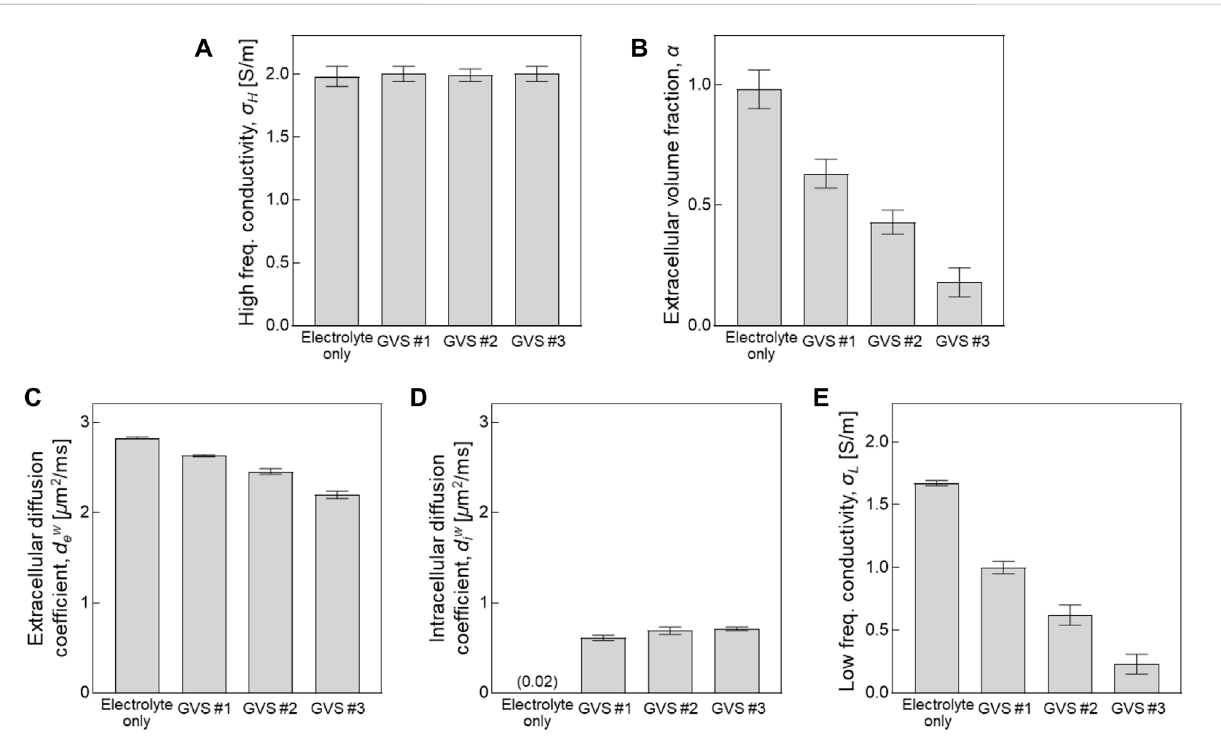
FIGURE 4 Comparison of CTI parameters depending on different densities of GVS. Bar graph represent the values of each parameter obtained from the entire area of the four chambers.